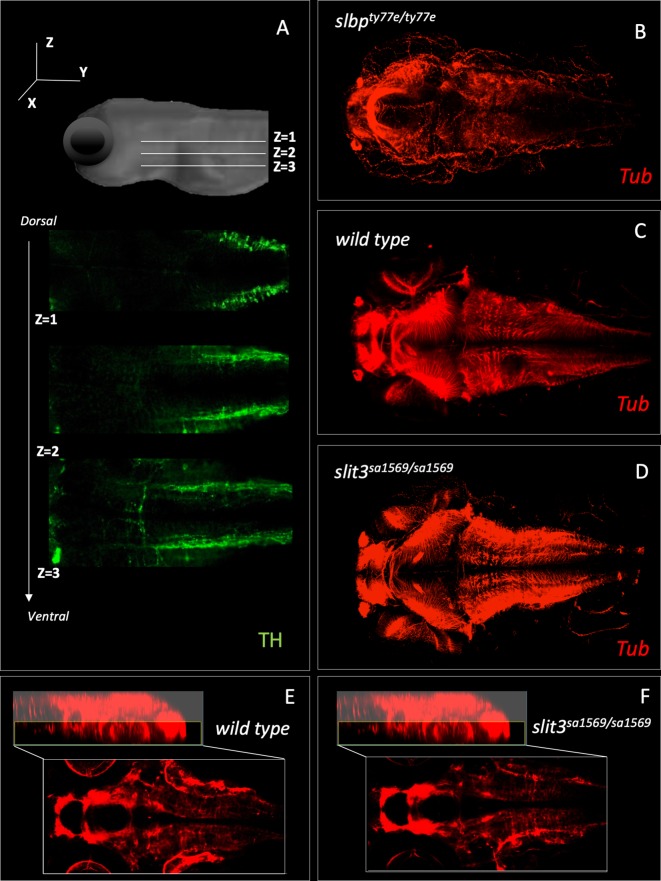
Fluorescent immunohistochemistry in three-day old wild type and homozygous mutant slit3sa1569 labelled with tyrosine hydroxylase (A) and tubulin (B–F).(A) Example of three Z-planes used to quantify catecholaminergic projections crossing the midline. (Stacks 1–3). (B) Anti-tubulin staining of slbpty77e/ty77e mutant larvae, known to have fewer neurons and axonal defects (Turner et al., 2019). (C–D) Anti-tubulin staining of wild type and homozygous mutant slit3sa1569. (E–F) Zoom-in of C-D for midline in the ventral forebrain, where slit3 is known to be expressed (Miyasaka et al., 2005).